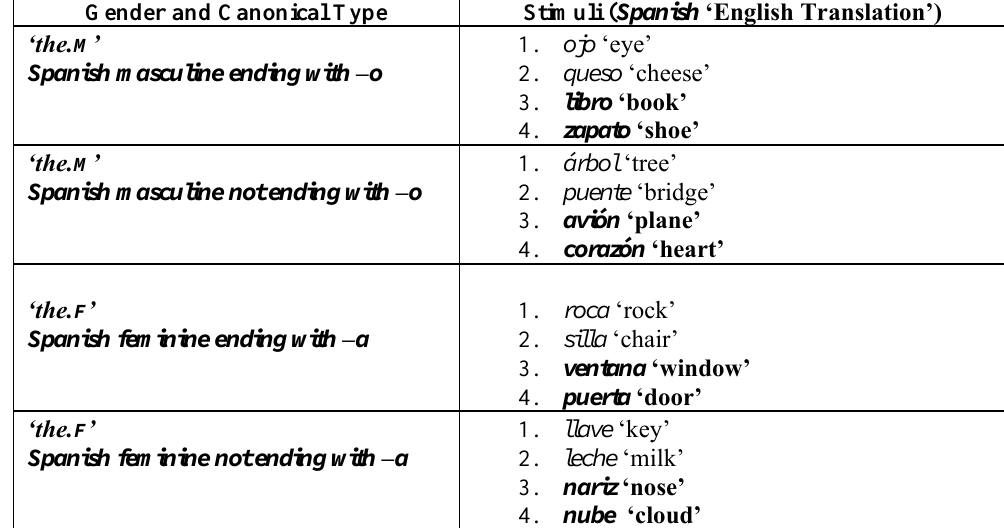
Table 2 . Objects and conditions used in toy tasks (12 objects in forced-toy task and 16 objects in natural toy task, marked in bold)